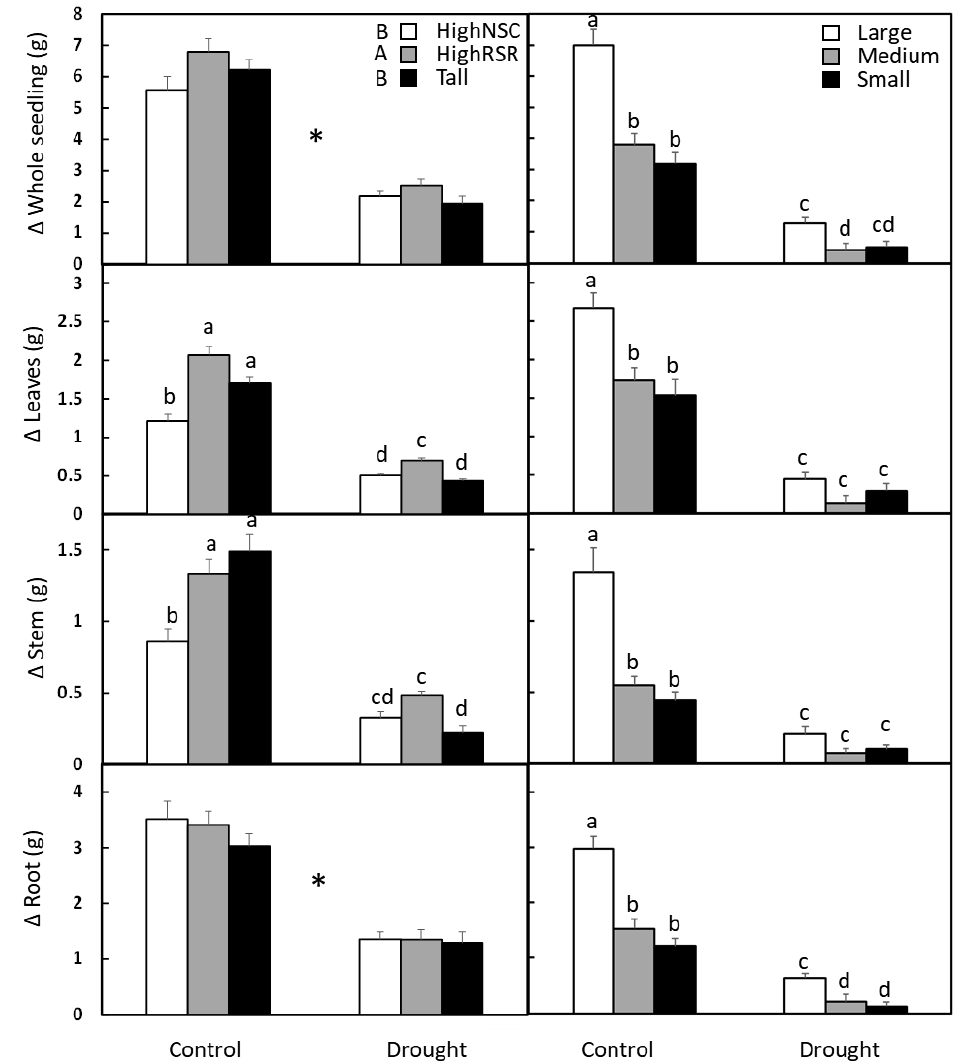
Figure 1. Average ( ± SE) changes in structural biomass (i.e., growth ( ∆ Biomass)) at the whole seedling and organ level for three aspen (LEFT column) and three pine (RIGHT column) seedling types under well-watered (control) and dry (drought) conditions. Species and organs were analyzed separately. An * and/or different letters on legend labels indicate significant differences among means of main effects (drought, seedling type), while different letters above bars indicate significant differences among all treatment combination means (Table 1; Tukey’s HSD, p ≤ 0.10). Table 1. Summary of analysis of variance for change in structural biomass (i.e., structural growth (∆Biomass) and change in NSC concentrations (∆NSC concentration ) of aspen and pine seedlings by seed- ling type and drought. Significant effects ( p ≤ 0.10) are indicated in bold, n = 10 per seedling type/drought treatment combination, except where noted.